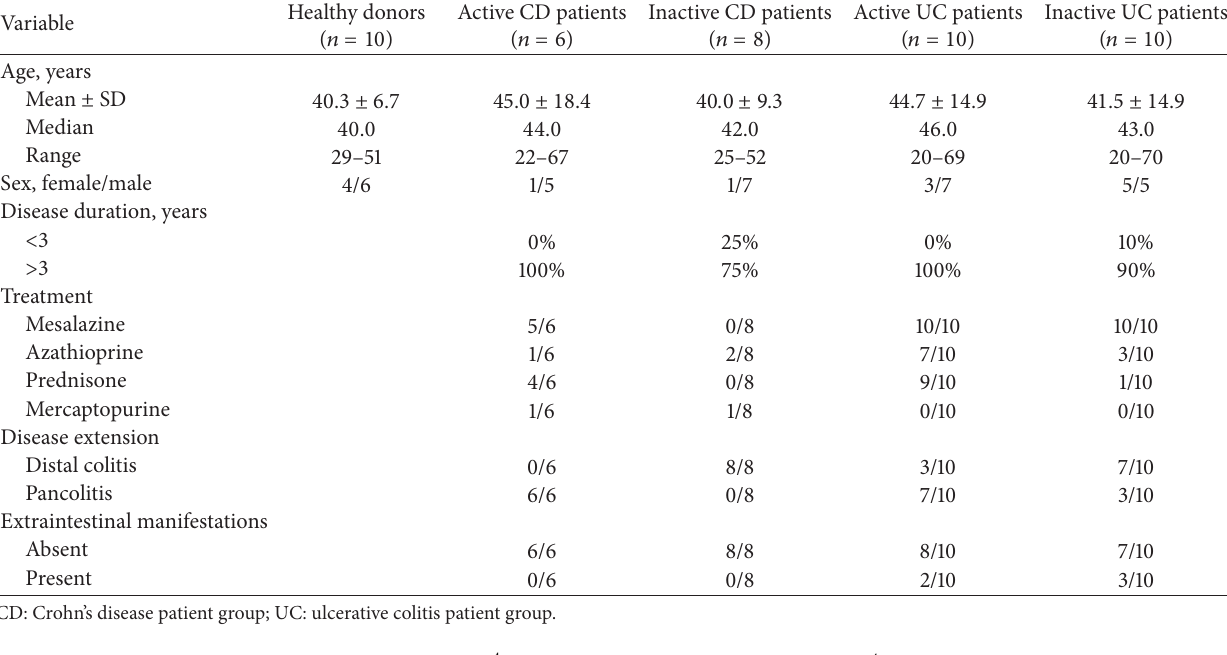
Table 1: Demographic and clinical characteristics of Crohn’s disease and ulcerative colitis patients.